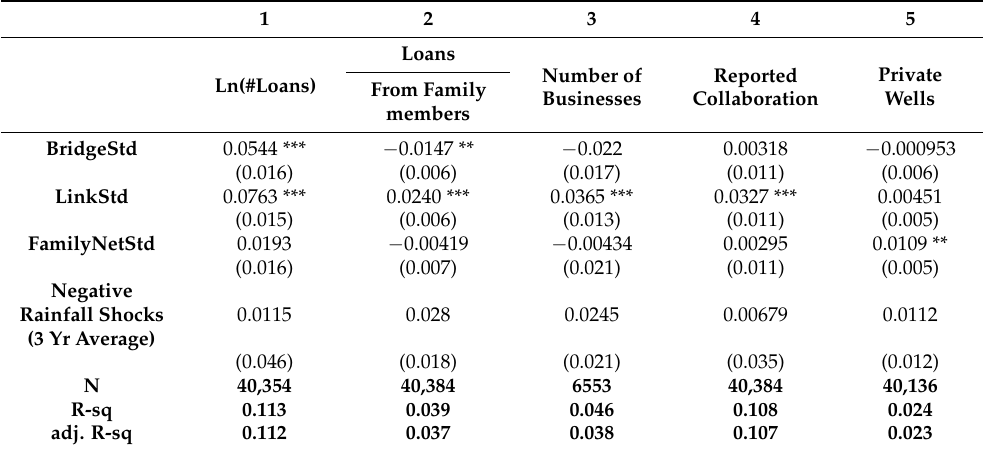
Table A7. Results assessing the impact of key measures of social capital and climate shocks (three-year averages) on key measures of social